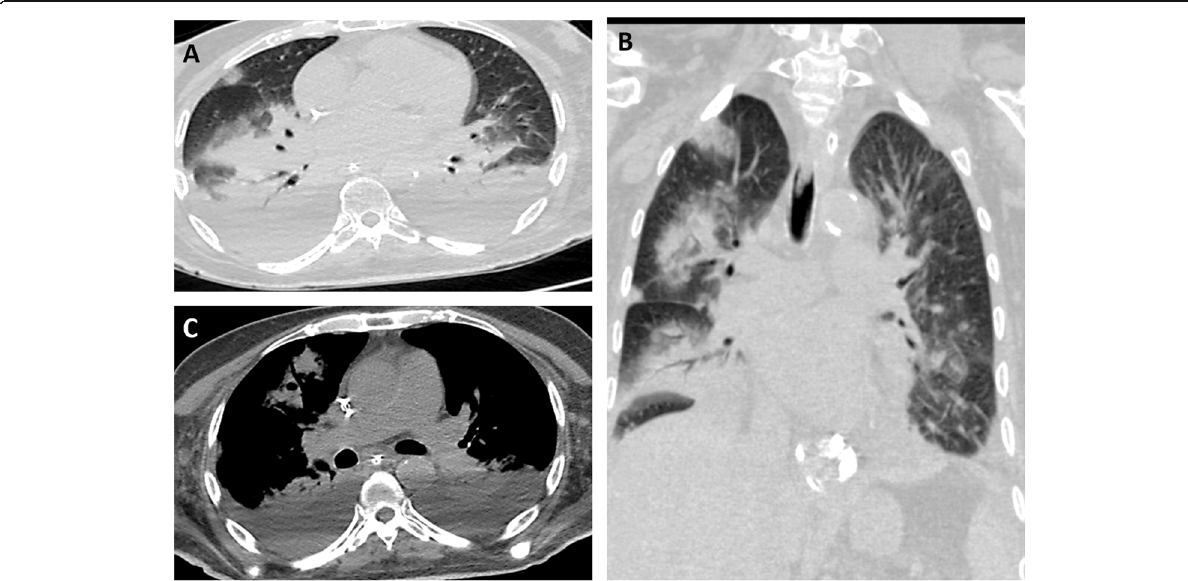
Fig. 5 Non-contrast CT done 5 days after initial complaint of a 60-year-old male with fever, cough, body aches, and shortness of breath. rt RT-PCR +ve ( A - C ): A , axial and B , coronal lung window and C , axial mediastinal window show bilateral perivascular consolidation (organizing pneumonia pattern) with air bronchogram sign involving both middle and lower lobes with bilateral pleural effusion